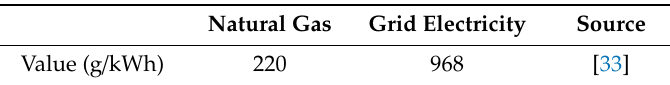
Table A1. CO 2 emission factor.